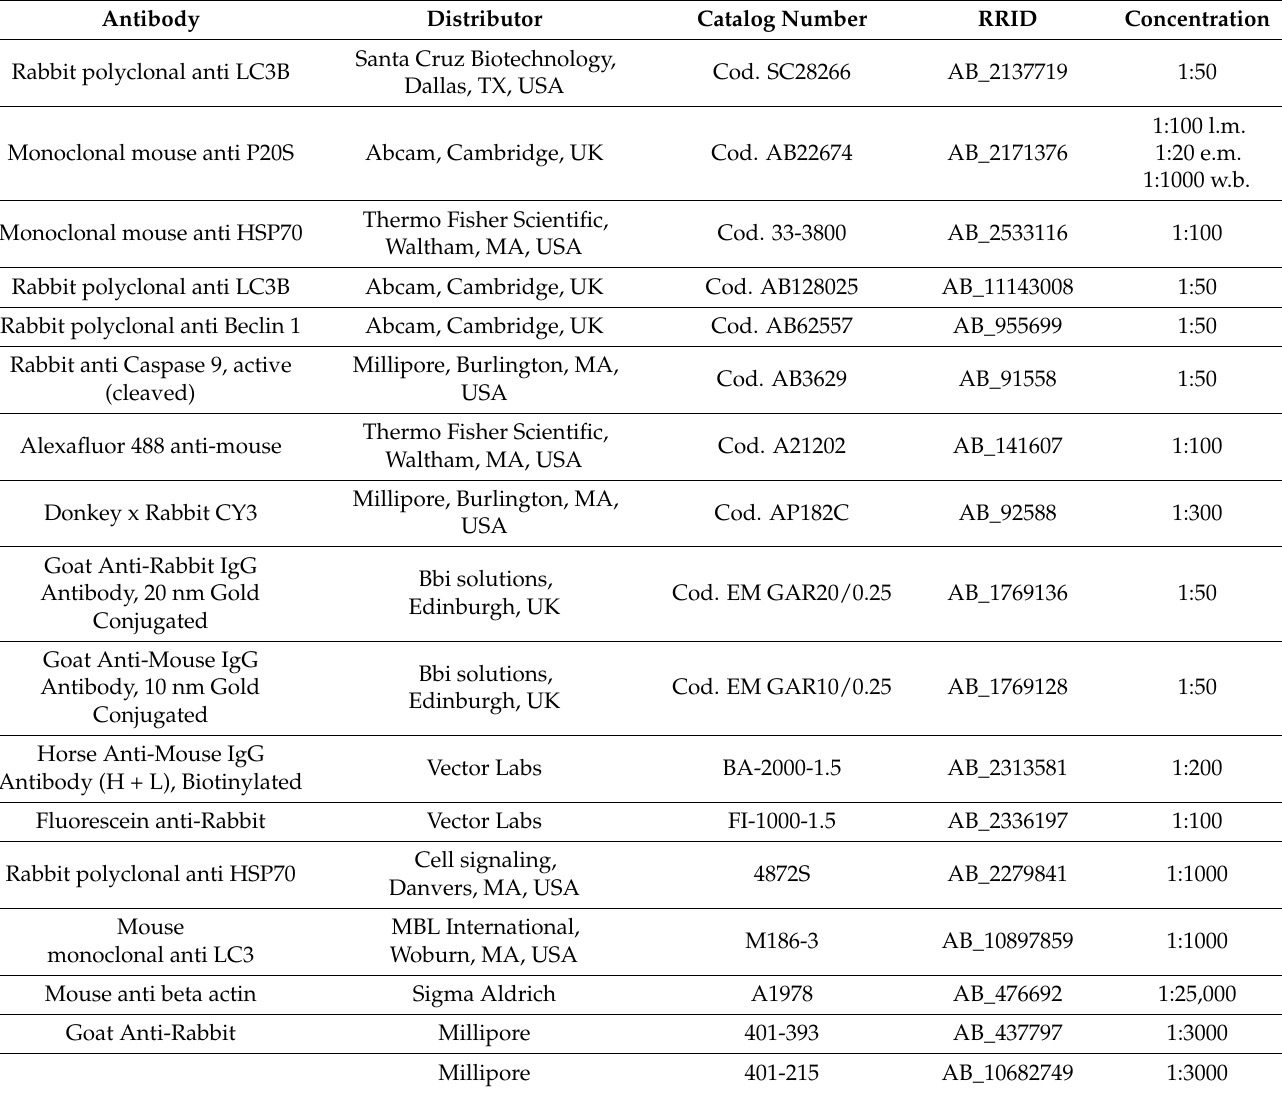
Table 1. Primary and secondary antibodies used in the